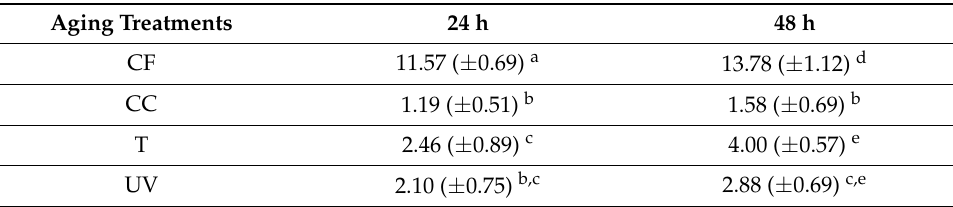
Table 2. Comparisons of color change ( ∆ E*) values of aligners subjected to different aging treatments at 24 and 48 h. (CF, coffee; CC, Coca Cola ® ; T, tea; UV, UV radiation). Different uppercase (a, b, c, d, and e) letters indicate statistically significant differences among groups ( p < 0.05; one-way ANOVA and Tukey’s multiple comparison test).